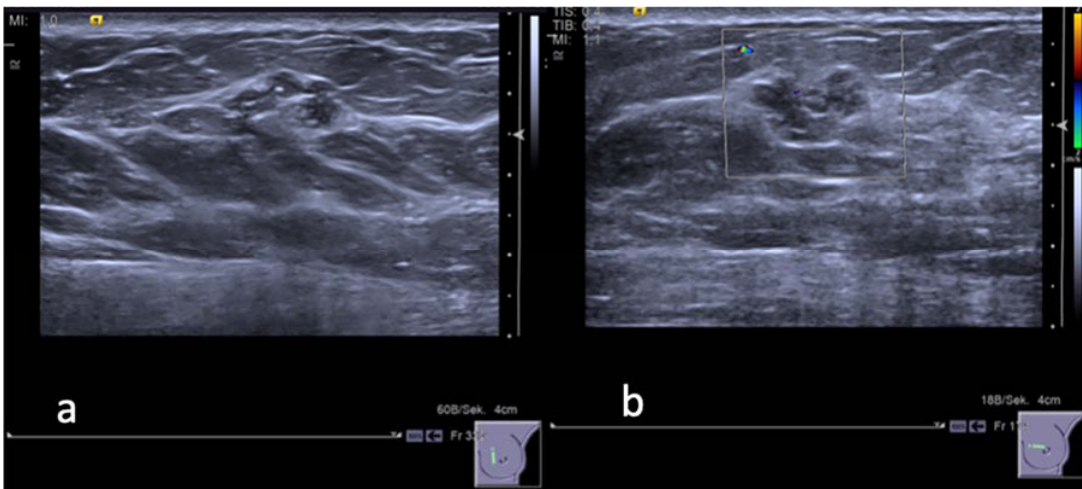
Figure 2. A 48 years old woman. ( a ) Gray ‐ scale ultrasound image shows a hypoechoic «mass» lesion with lobulated and partially non circumscribed margins in the inner para ‐ areolar region of the left breast. The maximum diameter of the lesion was 14 mm. ( b ) Color Doppler image reveals no peripheral vascularity of the lesion. The lesion was categorized by both readers as BI ‐ RADS 3. CNB: B3 lesion without atypia (adenosis, sclerosing adenosis, epithelial proliferation without atypia, small papilloma). Final histology after surgery revealed a highly differentiated, intraductal carcinoma DCIS ‐ G1, in addition to extensive adenosis, small papilloma, and lobular neoplasia. Table 1. Descriptive statistics for histopathological diagnoses among all B3 lesions diagnosed ad US ‐ CNB. Final histologic results for each sub ‐ category and associated positive predictive value (PPV) for breast malignancy. FINAL DIAGNOSIS US ‐ CNB N % PPV Non Malignant Malignant